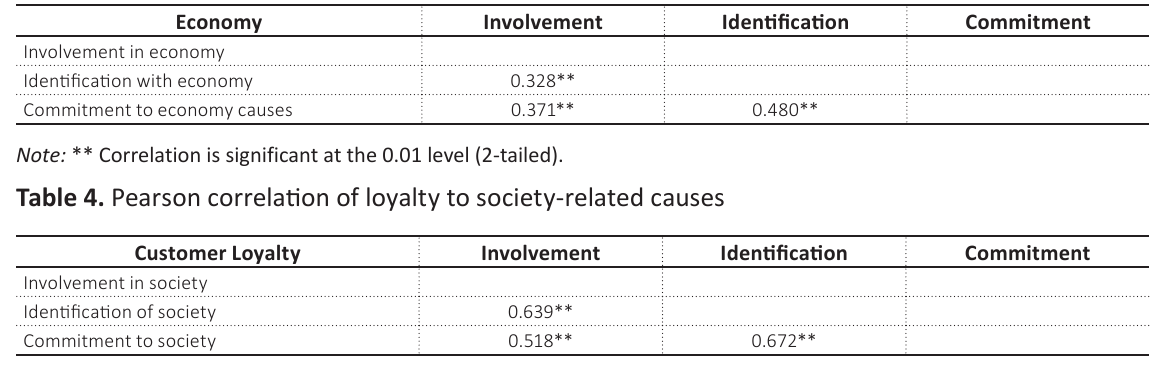
Table 3. Pearson correlation of loyalty to economy-related causes